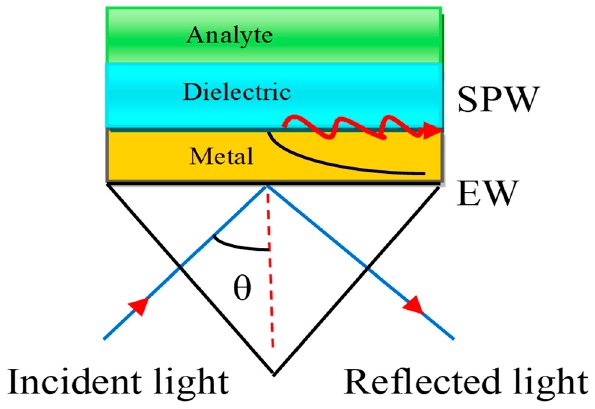
Figure 4. Kretschmann configuration. Here, EW stands for Evanescent Wave and SPW refers to the Surface Plasmon Wave.